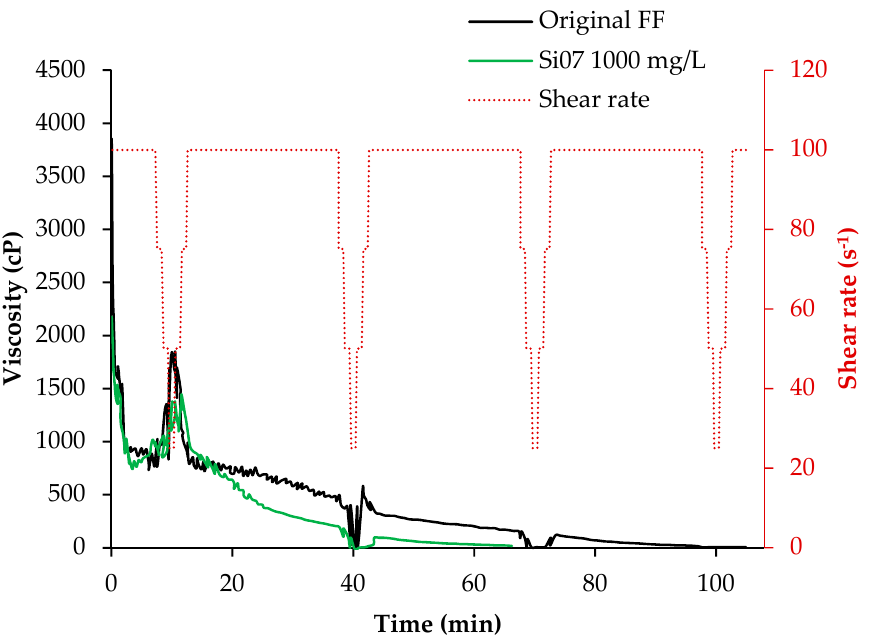
Figure 9. Rheological behavior of the original FF with and without 1000 mg/L of Si07 under pressure and temperature of 87.7 °C and 5500 psig.